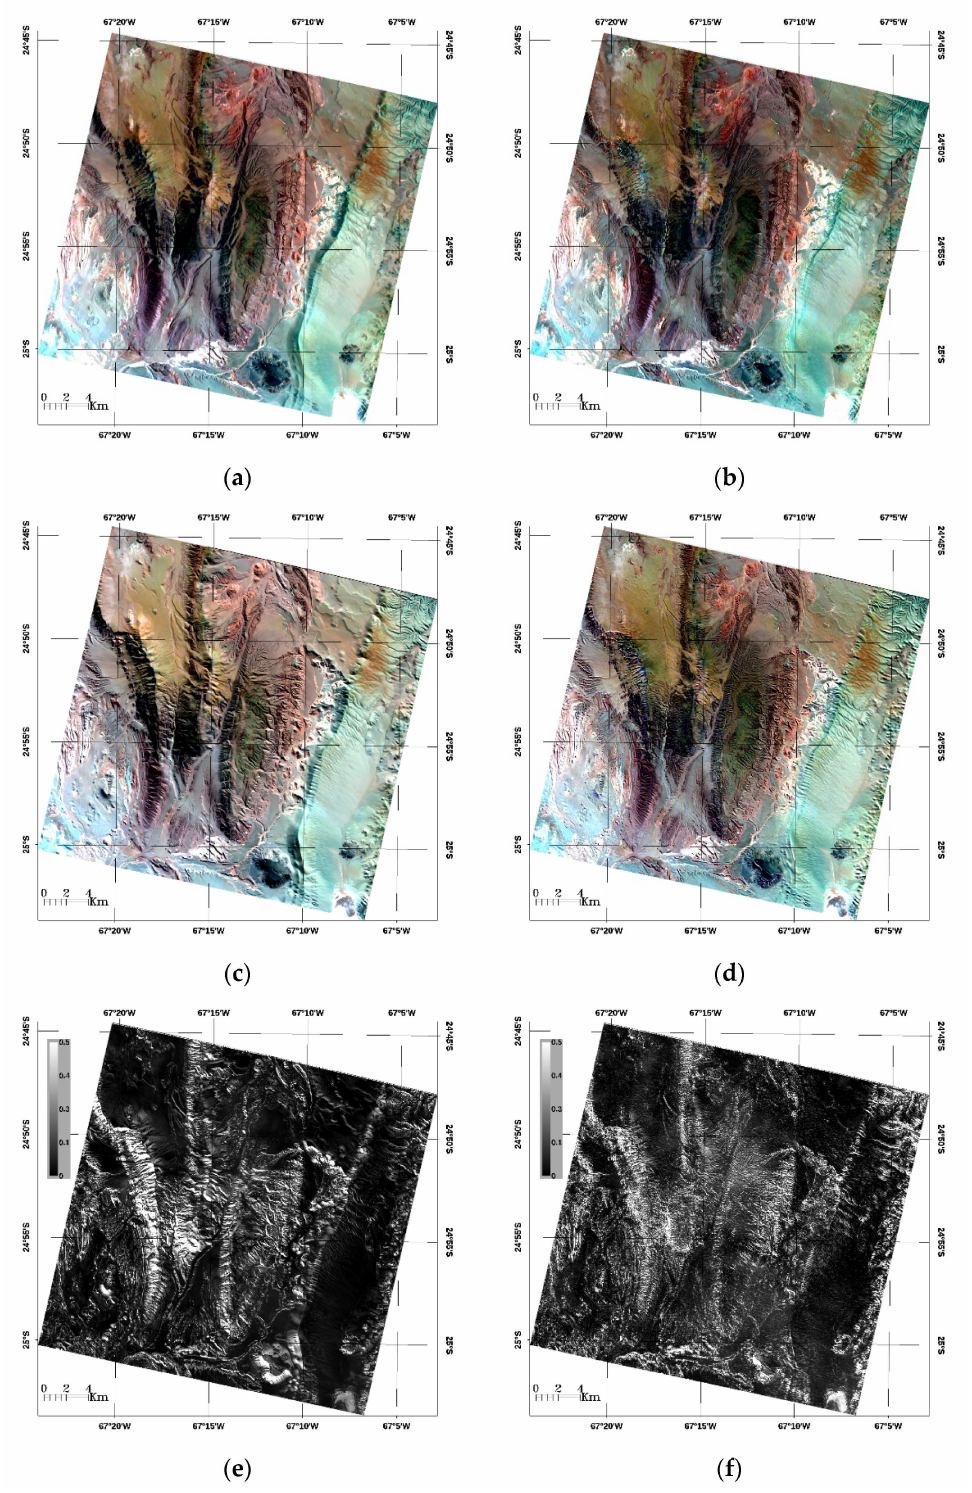
Figure 2. Comparison of PRISMA SAC and ATC reflectance images obtained with ImaACor: ( a ) summer SAC; ( b ) summer ATC; ( c ) winter SAC; ( d ) winter ATC; ( e ) band mean normalized absolute difference image without and ( f ) with topographic